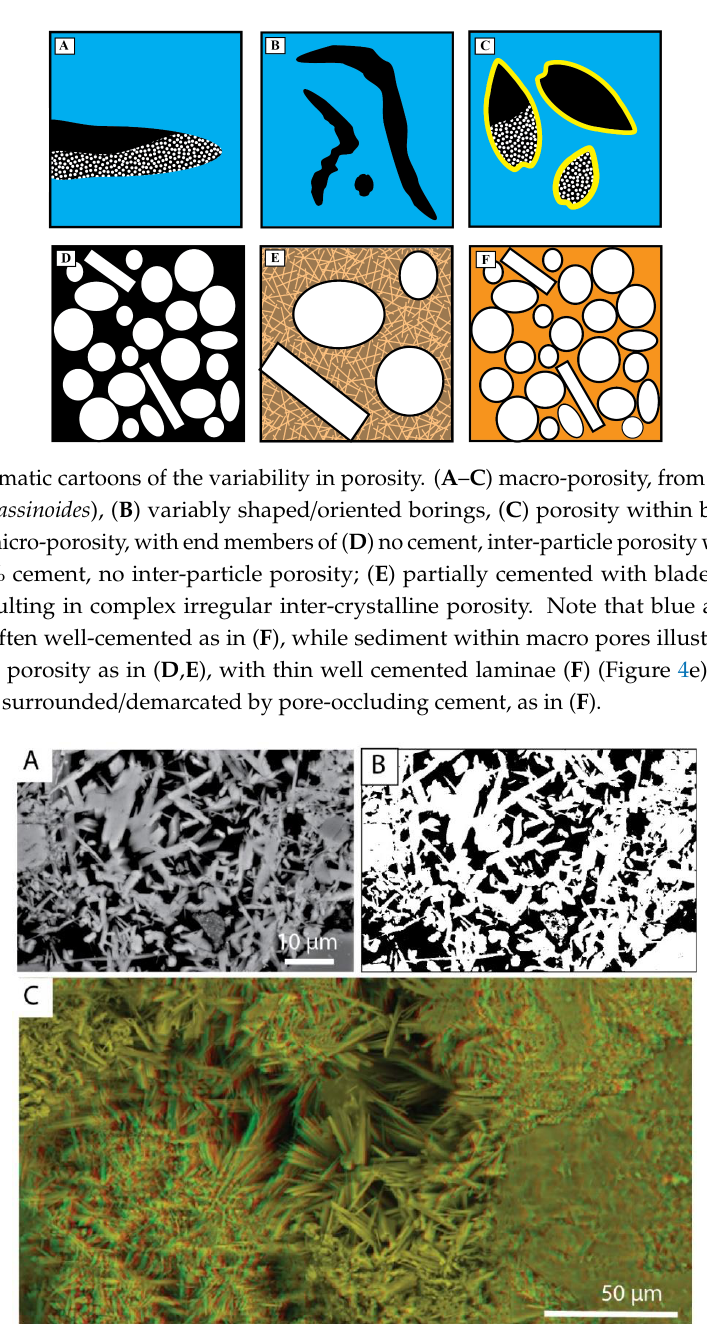
Figure 7. Illustration of complex pore morphology associated with acicular cements. ( A ) Scanning electron microscope (SEM) image, ( B ) binarised image of ( A ) for porosity (black), porosity = 62%, signifying that much of the pore space is open, but highly compartmentalised and baffled. Pores are difficult to model in terms of permeability using digital rock modelling (DRM) techniques, as they do not conform to the standard spherical pore models commonly used. ( C ) Three-dimensional stereo image, illustrating the complexity of pore spaces in three dimensions (requires green-red stereo glasses).